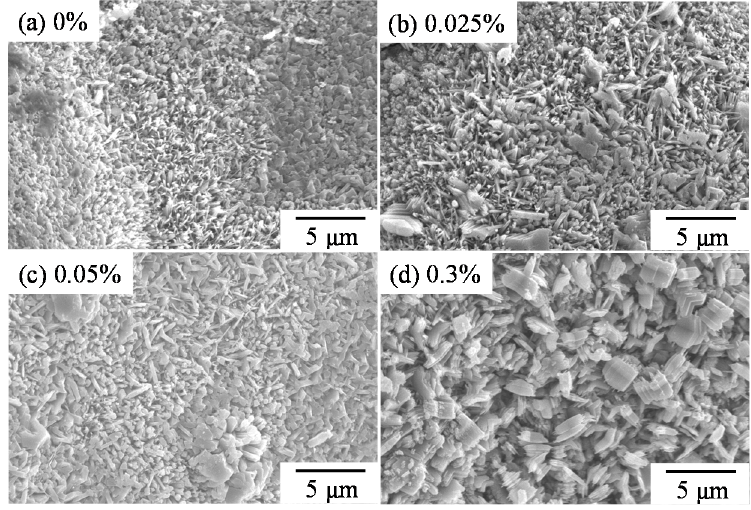
Figure 4. SEM images of surfaces of M10- x Cr-1073 K/3 h samples. ( a ) 0%; ( b ) 0.025%; ( c ) 0.05%; ( d )